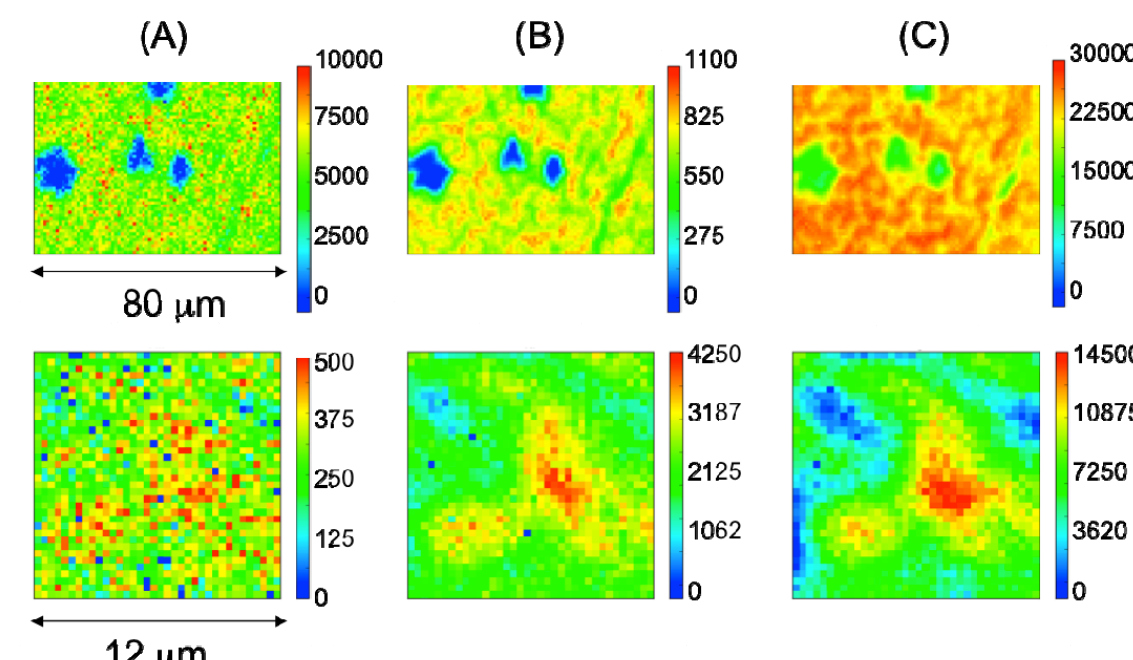
Figure 5. XRF maps of electrodeposited Mn–Ni–Mg/PPy composites (energy: 1.4 keV, step size: top 1 μ m, bottom 0.3 μ m): ( A ) Mn; ( B ) Ni; ( C )